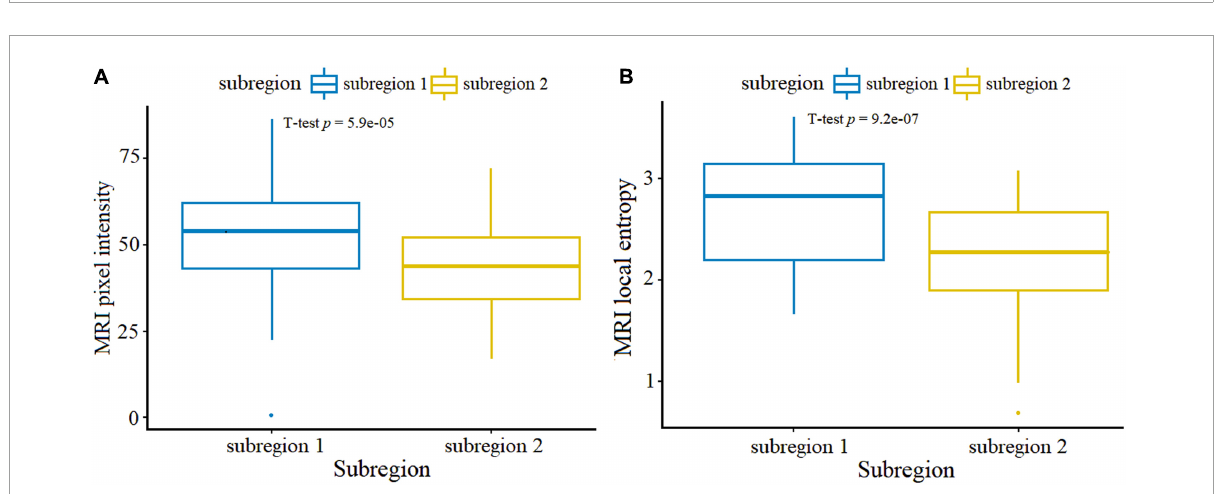
FIGURE4 Boxplots showed MRI pixcel intensity (A) and local entropy (B) between the partitioned S1 and S2 in all patients. P -values were obtained using the t